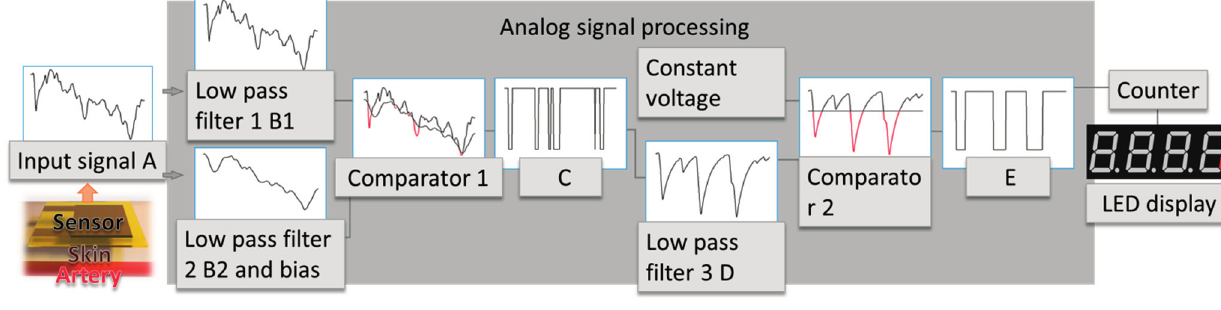
Figure 5. Block diagram of the heart rate sensor. The pulsation of the artery is transmitted to the sensor through skin, and generate voltage signal A. B1, B2, C, D, E are the signals inside the ASP module. B1 shows the signal generated from low pass filter 1, B2 shows the output of low pass filter 2. Comparator 1 generates C, which is the compare result of B1 and B2. The red part shows where B2 is higher than B1. D is generated by low pass filter 3. Comparator 2 generates E, which is the compare result of D and a constant voltage. Red parts show where the constant voltage is higher than D. E is used by the